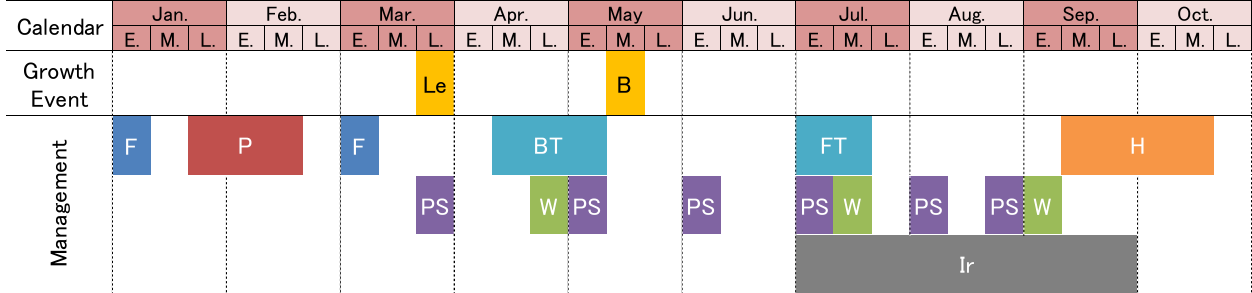
Figure 3. Management schedule of a single season of persimmon (‘Tone Wase’) cultivation based on the information provided by farmers in the Gojo-Yoshino region. Abbreviations are E: Early, M: Middle, and L: Late, Le: leafing, B: blooming, F: fertilization, P: pruning, BT: bud thinning, FT: fruit thinning, H: harvesting, PS: pesticide spraying, W: Weeding, and Ir: Irrigation. The remote-control weeder (Sanyo Equipment AJK-600, Figure 4b), the Speed Sprayer (SS: Kioritz SSV665FSC, Figure 4d) for pest control, a remote-control mini crawler carrier